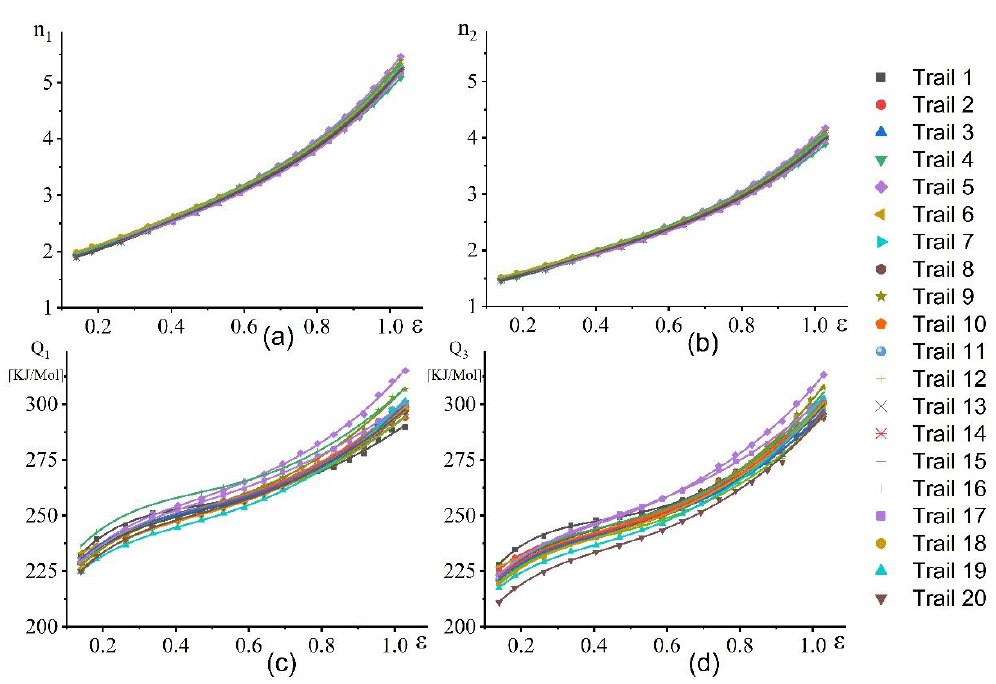
Figure 13. The error between experimental and tested flow stress after cross-validation of ( a ) power law model and ( b ) hyperbolic sine law model . The cross-validation technique revealed that both models exhibited a low level of errors. Thus, both models can be used to correctly predict the flow behaviour of this alloy (Figure 13). The power law model exhibited only one critical region (lowest temperature-highest strain rate) with an error of 7% (Figure 13a). In the case of hyperbolic sine law, the extreme points (lowest tested temperature- highest strain rate and highest temperature-lowest strain rate) exhibited higher error compared with the other points (Figure 13b). Therefore, the proposed power law model had better predictability of the stress values under superplastic deformation. 4. Discussion The material constants in the CE model indicate the deformation-controlling mechanisms in the studied temperature-strain rate range. The mechanisms can be evaluated by using the stress exponent values n 1 , 2 and an effective activation energy ( 𝑄 1,3 ) [ 39 ]. Grain boundary sliding (GBS) mechanism is considered to be dominant at n 1,2 values close to 2. For dislocation viscous glide (DVG), it is assumed